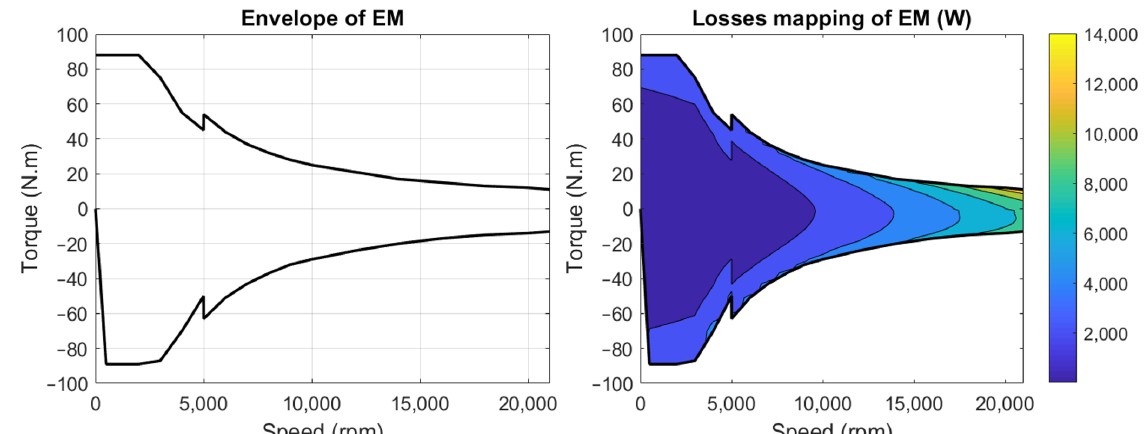
Figure 3. Left : Example of EM operation envelope. Right : Example of EM losses mapping. The maximum torque region can be identified, as well as the maximum power region. The torque peak in the maximum power region corresponds to a change in the inverter’s switching strategy ( Speed FWM = 5000 rpm).